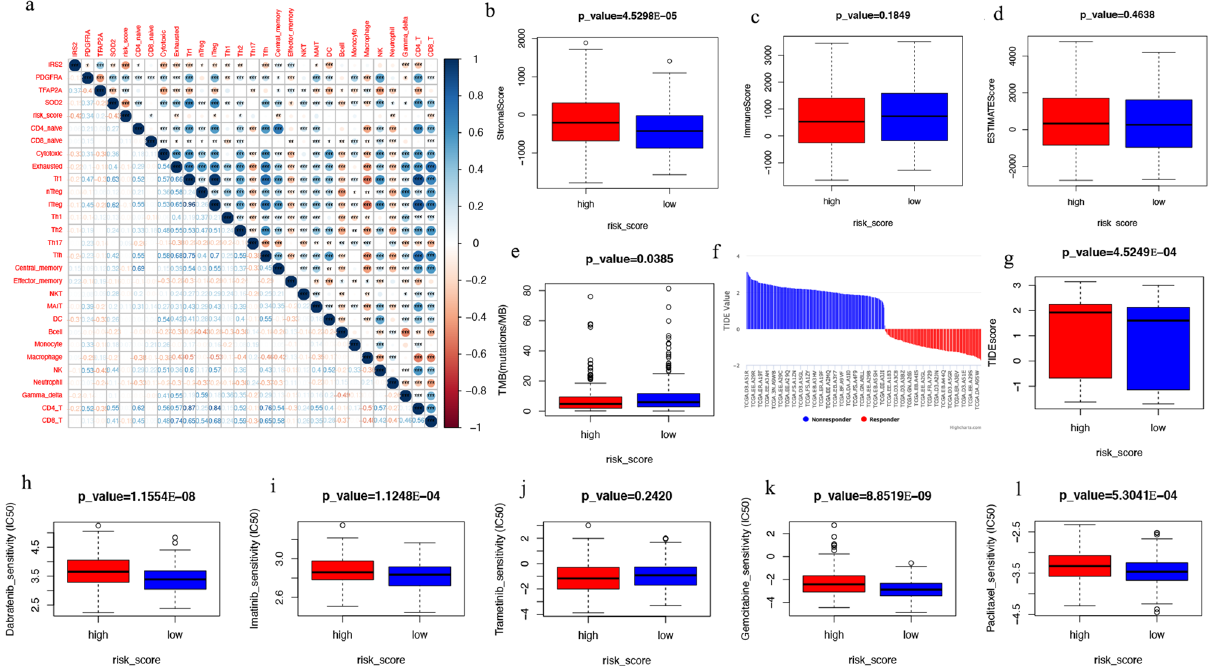
Figure 7. Tumours, immune microenvironment landscape, and drug efficacy prediction. ( a ) Correlation between the expression of ARGs and the degree of immune cell infiltration. ( b–d ) Association of risk score and tumour microenvironment. ( e–g ) Differences in TMB and TIDE scores between different risk score groups. ( h– l ) Sensitivity analysis of five common targeted and chemotherapeutic drugs between different risk score groups. ARG ageing-related gene, TMB tumour mutation burden, TIDE Tumour Immune Dysfunction and